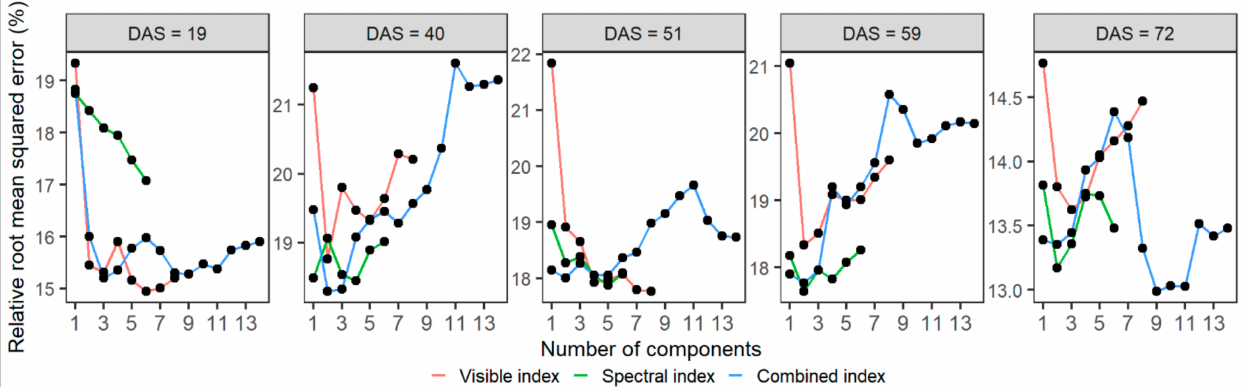
Figure 5. The averaged cross-validated relative root mean square error (RRMSE) of the number of components in training the PLSR model to estimate the aboveground dry weight of wheat. The mean RRMSE of each number of components was calculated from the 10 repeats of 8-fold cross-validations of the PLSR models. Models were trained using mono-temporal datasets of visible ( red ), spectral ( green ), and combined ( blue ) indexes at prediction dates (days after sowing,